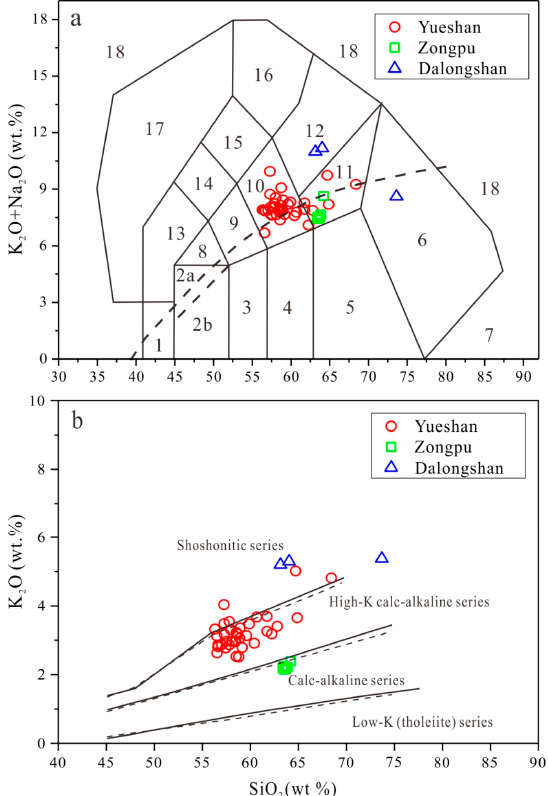
Figure 4. TAS ( a ) and K 2 O-SiO 2 ( b ) classification diagrams for the Yueshan, Zongpu and Dalongshan magmatic rocks. Fields in the TAS diagram are after [53]. The fields for K 2 O-SiO 2 diagram are after [54], and the dashed line is from [53]. 1—olivine gabbro; 2a—syenogabbro; 2b—gabbro; 3—gabbro–